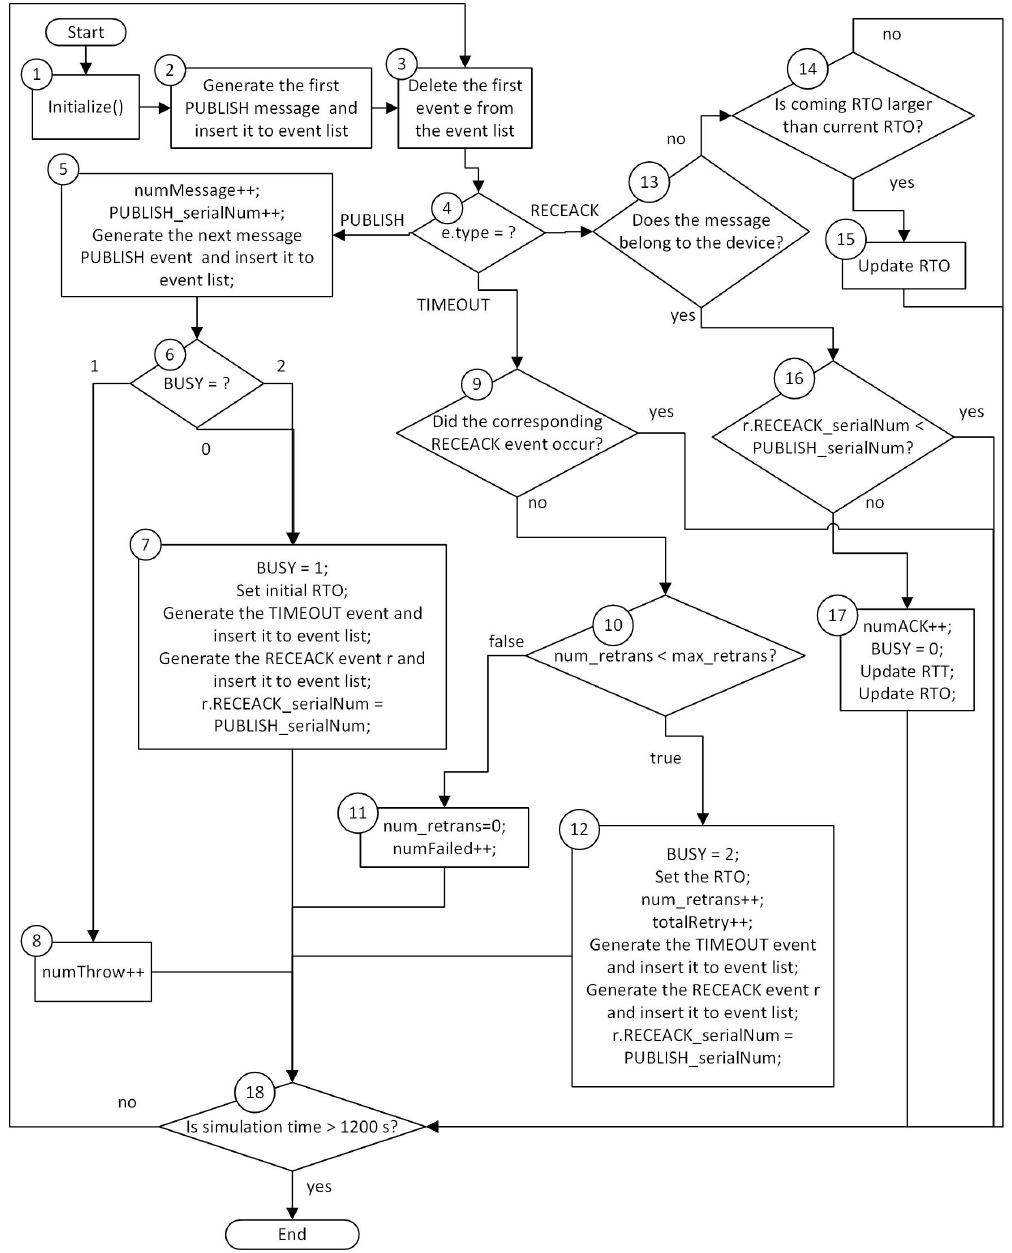
Figure 4. Simulation flow